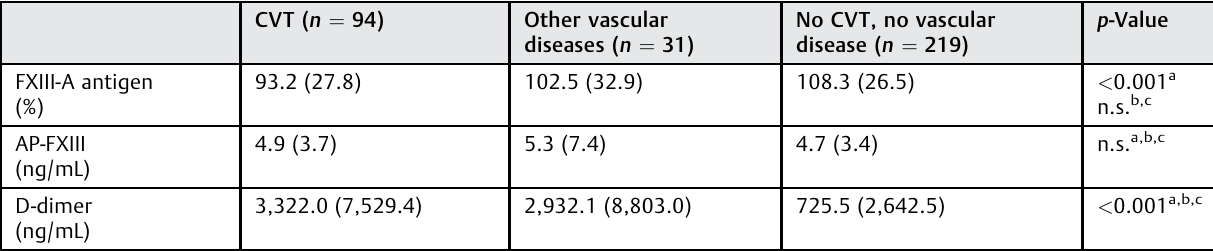
Table 2 Strati fi cation of non-CVT patients CVT ( n ¼ 94) Other vascular diseases ( n ¼